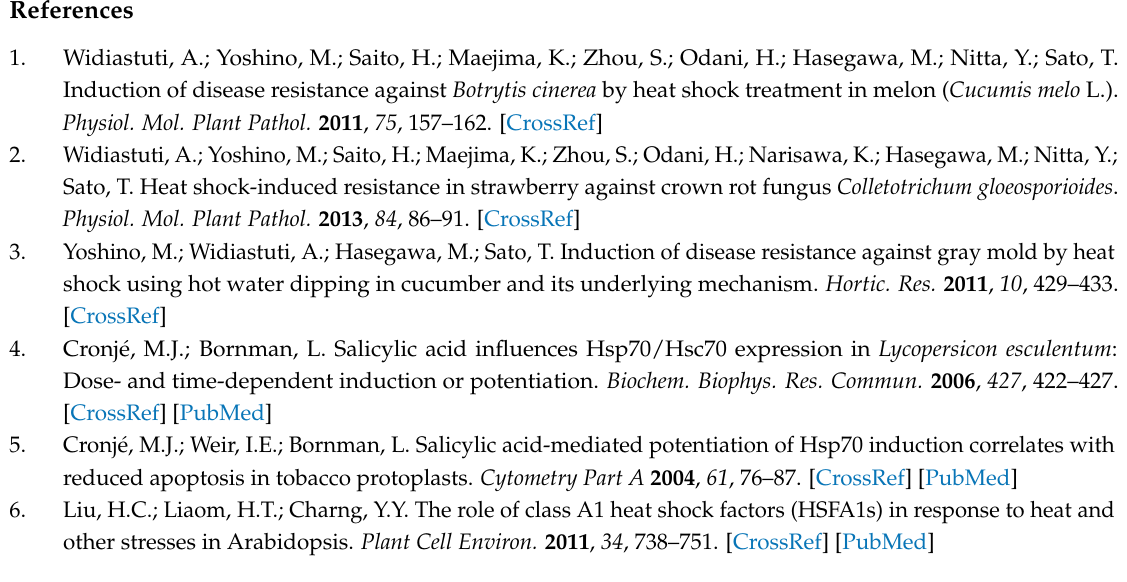
Supplementary Materials: The following are available online at www.mdpi.com/link, Figure S1: Changes in the relative expression level of (a) PR1b1 , and (b) HsfA2 .